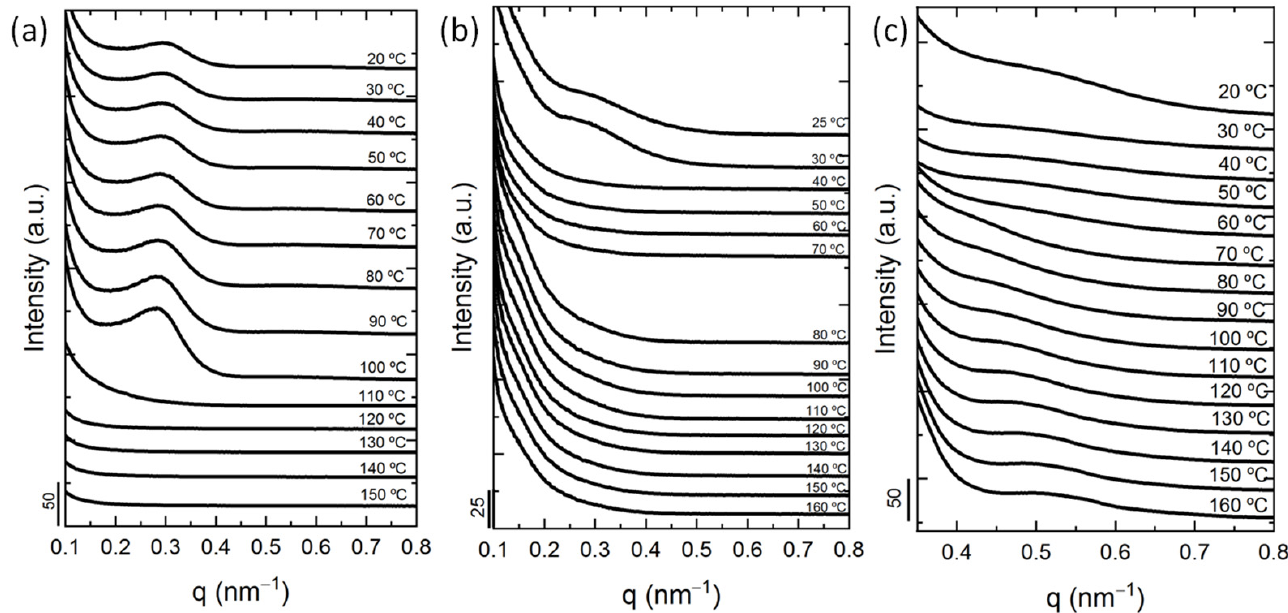
Figure 1. SAXS ramp down patterns at 20 °C/min for ( a ) PE 7.1 , ( b ) PE 327.1 -b- PEO 6815.1 , and ( c ) PE 227.1 -b- PEO 4615.1 -b- PCL 3210.4 (T1) at the indicated temperatures.